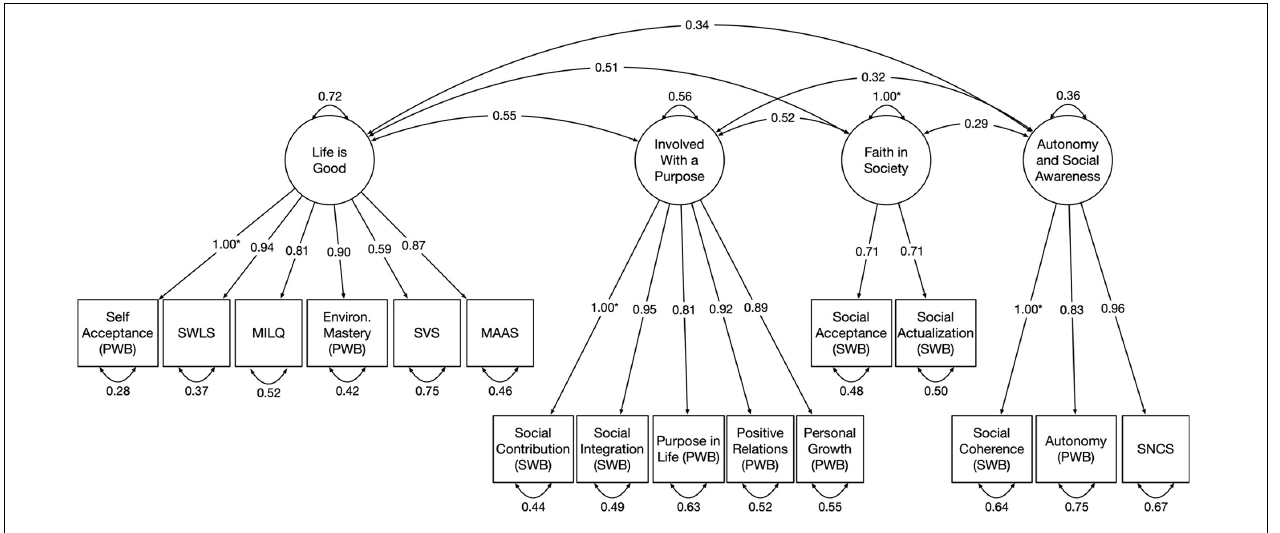
FIGURE 3 | Diagram of confirmatory factor analytic